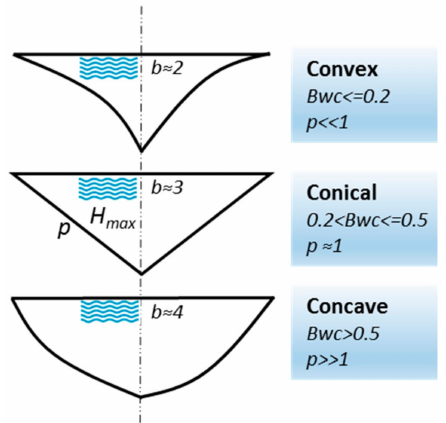
Figure 6. The schematic representation of each reservoir profile in respect to the bathymetric capacity to store water Bwc ( H max is the maximum reservoir depth, p is the average reservoir shape and b represents the average reservoir